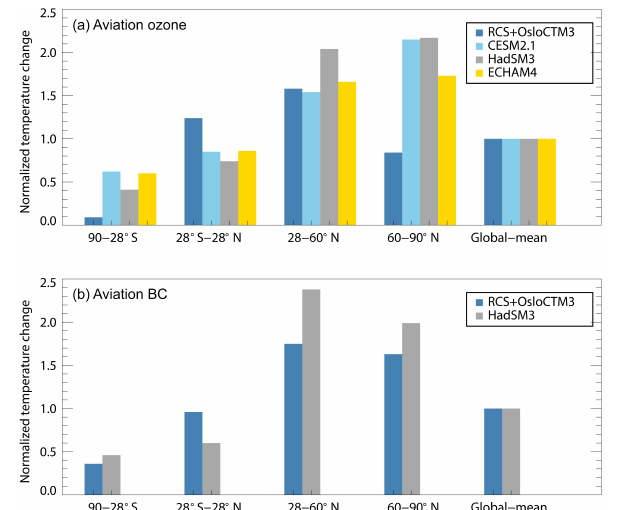
Figure 4. (a) Comparison of the regional pattern of surface temper- ature response to a global aviation ozone perturbation as calculated using the regional climate sensitivities (RCS) from GISS with RF derived from OsloCTM3 (i.e., using the ARTP concept) and sim- ulated by HadSM3, ECHAM4 and CESM1.2. Surface temperature response in each latitude band is normalized by the global-mean value. (b) Same as (a) but for